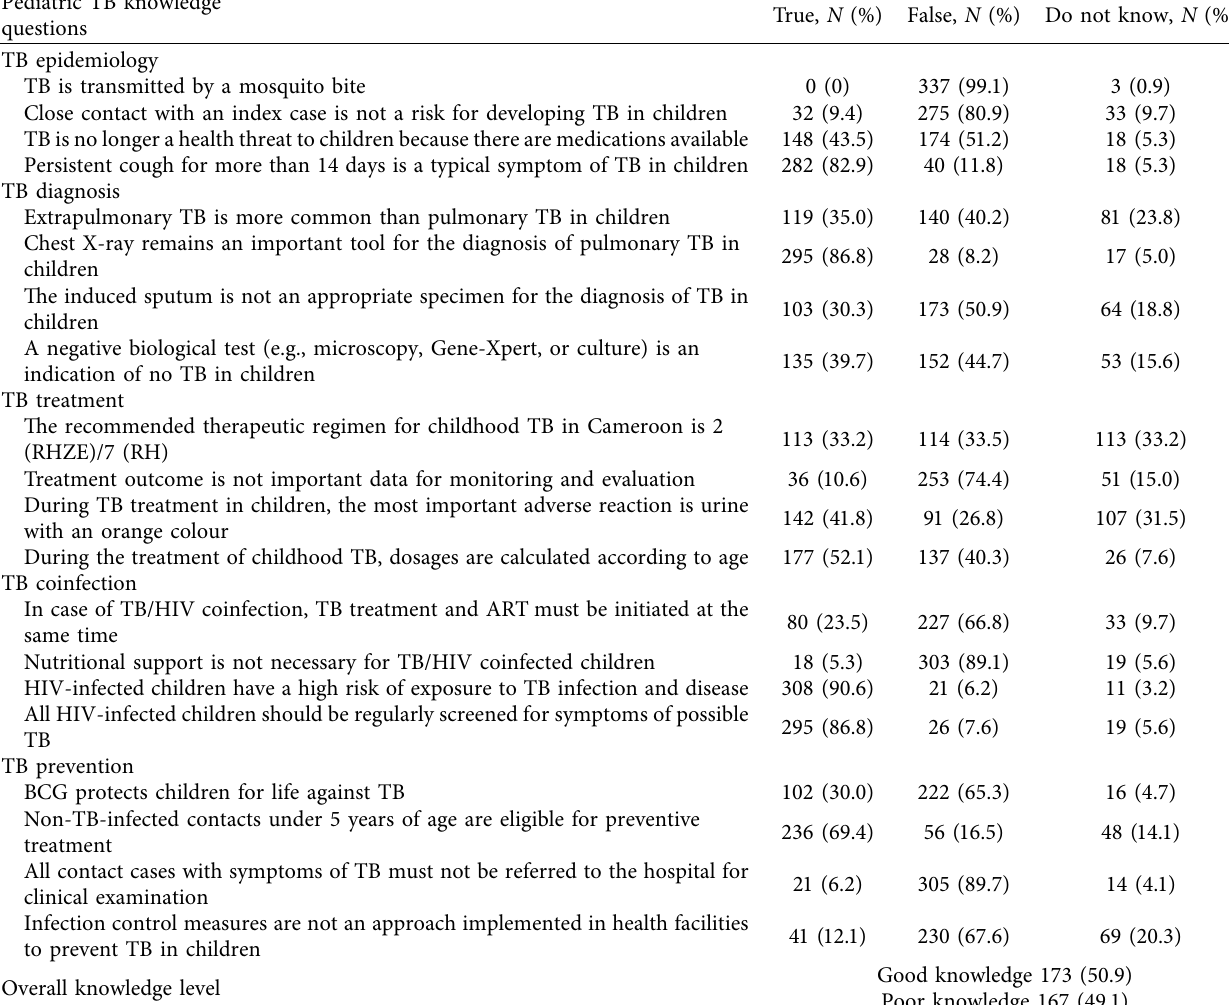
Table 2: Knowledge of HCWs on pediatric TB